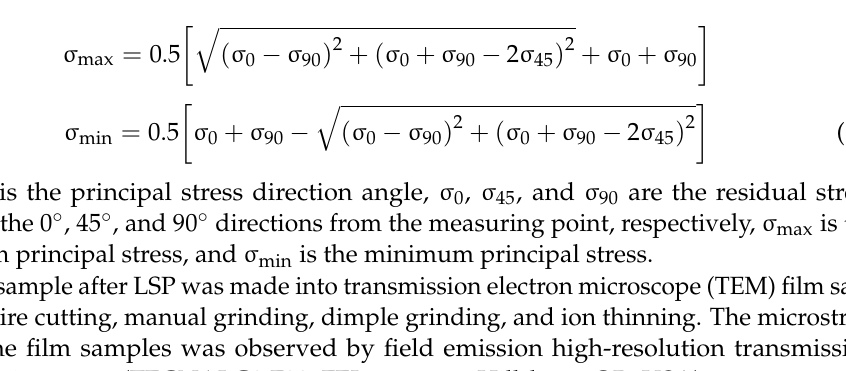
( c ) Figure 6. Distributions of residual principal stresses produced by different laser power densities: ( a ) Maximum residual principal stress distribution. ( b ) Minimum residual principal stress distribution. ( c ) Principal stress direction angular distribution. Figure 7 shows a comparison of the experimental and simulated results for the sur- face residual stresses after the surfaces were shocked with the different laser power den- sities. From Figure 7a, when the laser power density is 1.53 GW/cm 2 , the maximum resid- ual stress obtained via the simulation is −211.79 MPa, the maximum residual stress meas- ured experimentally is −219.01 MPa, and both maxima appear at the center of the spot. The residual stress value at a distance of 1 mm from the spot center is −209.51 MPa and